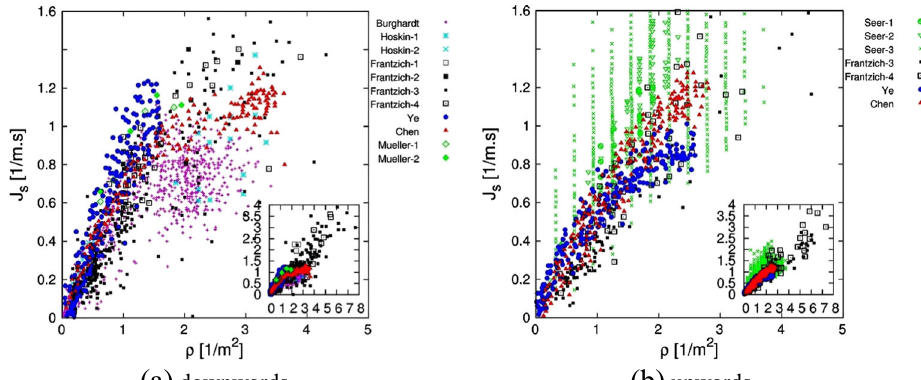
Fig. 6 Measurements of the fundamental diagram for stairs obtained from various field and experimental studies. Full range of observation points has been shown in the small diagram enclosed (Burghardt et al.